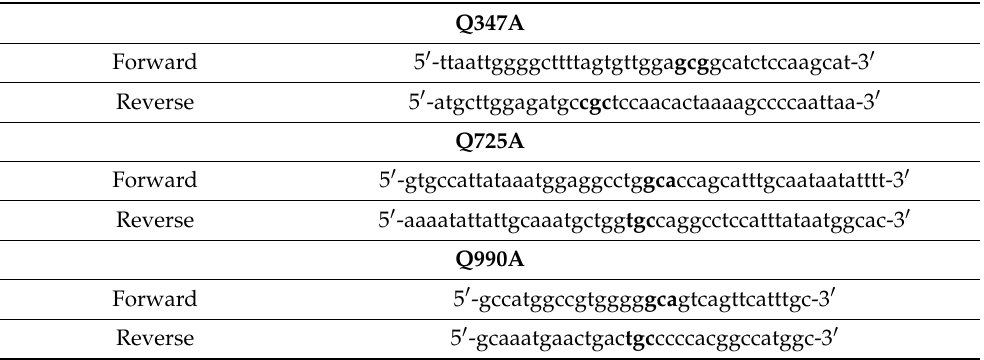
Table 1. Mutagenic oligonucleotides with the new alanine codons